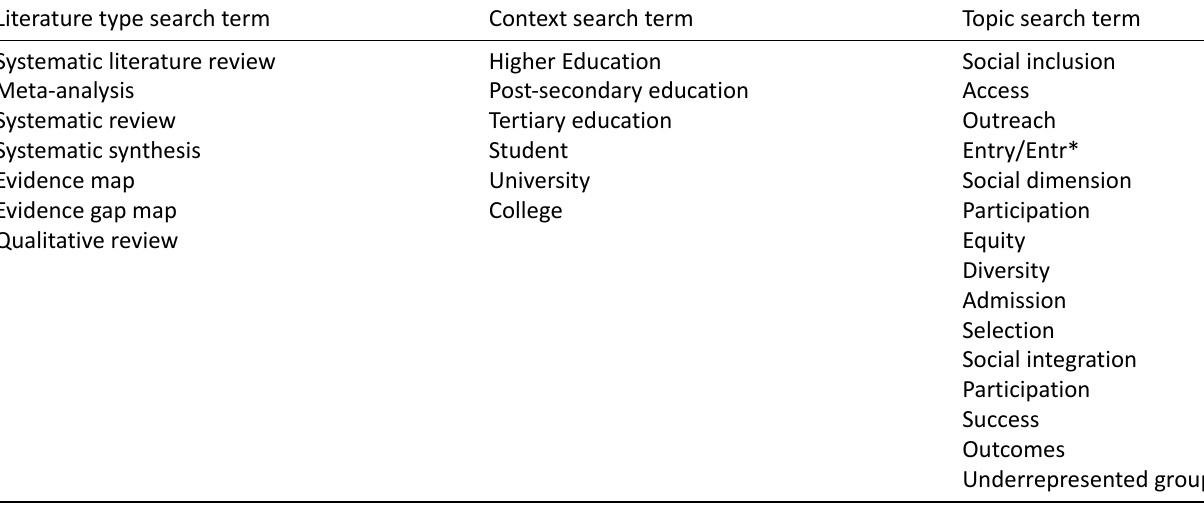
Table 1. Keywords used for database